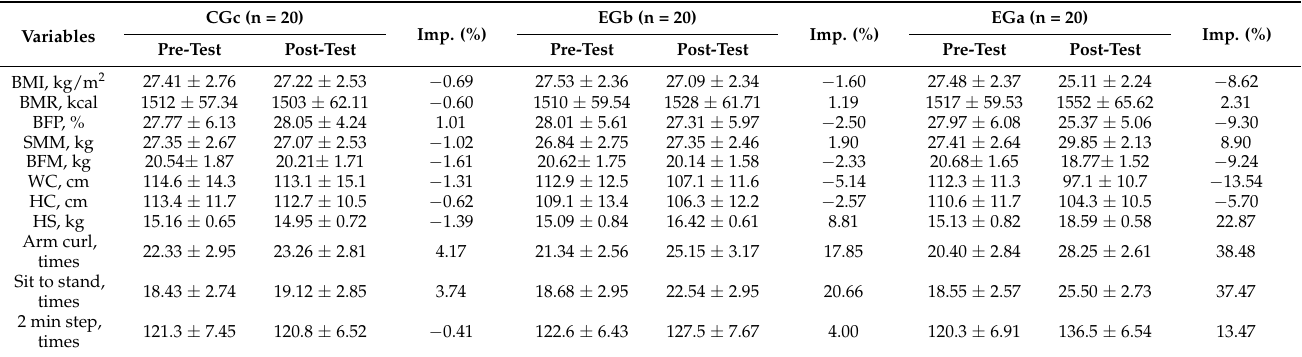
Table 4. Descriptive statistics for the three experimental groups pre-test and